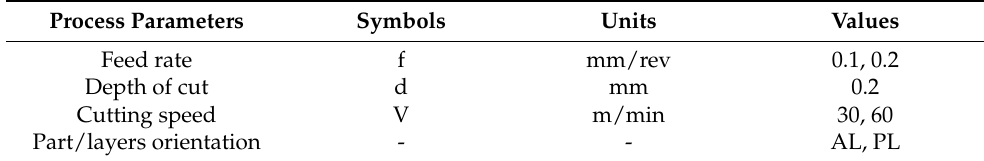
Table 3. Turning process